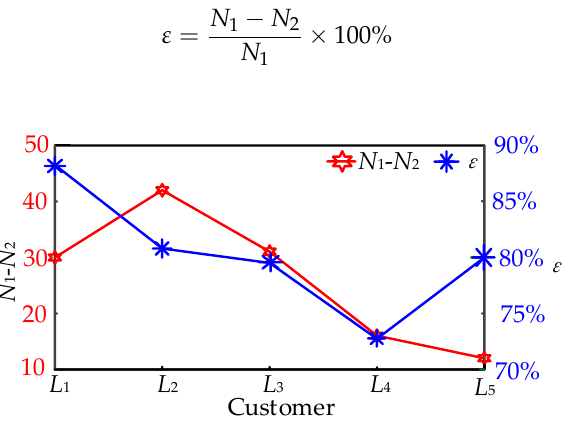
Figure 11. Reduction of the frequency of economic losses after taking the investment schemes for L 1 ~ L 5 .